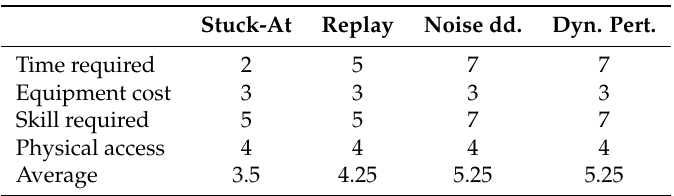
Table 7. Attack table